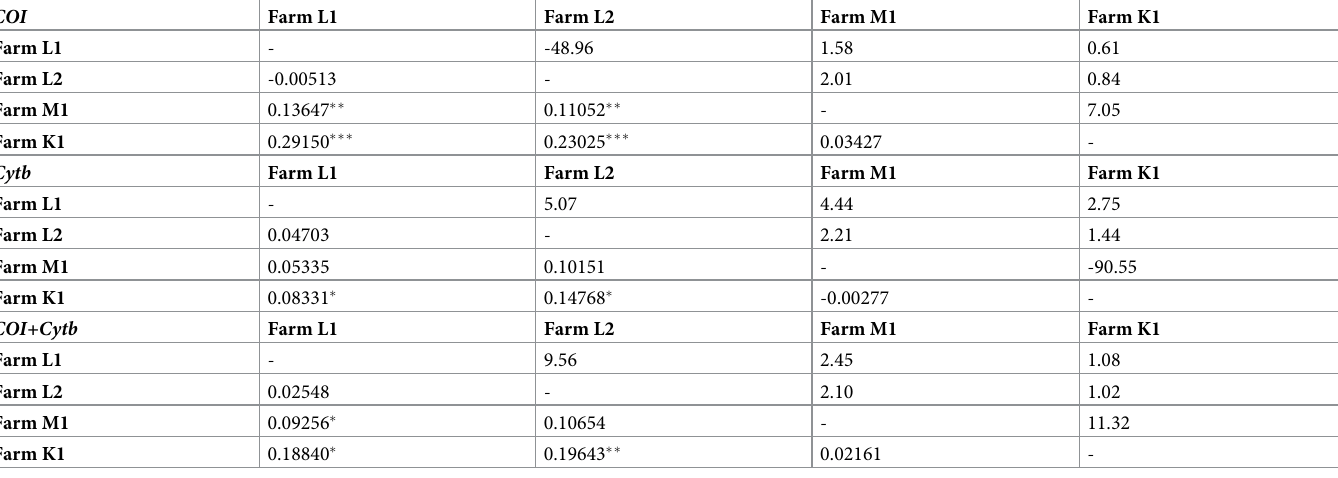
Table 5. Genetic differentiation (F ST ) and gene flow ( Nm ) based on COI, Cytb and COI+Cytb DNA sequences of Bathycoelia distincta from three different regions of South Africa. COI Farm L1